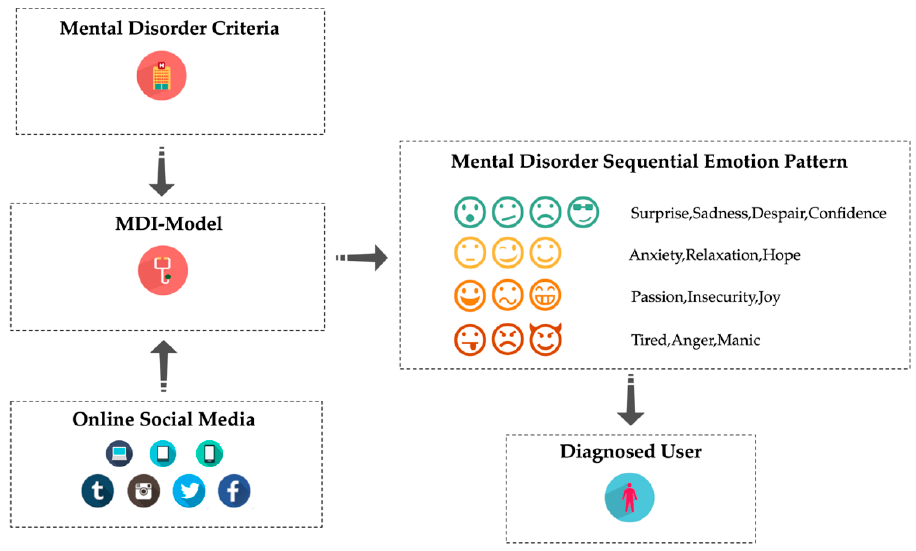
Figure 1. Pattern approach to identify mental disorder.